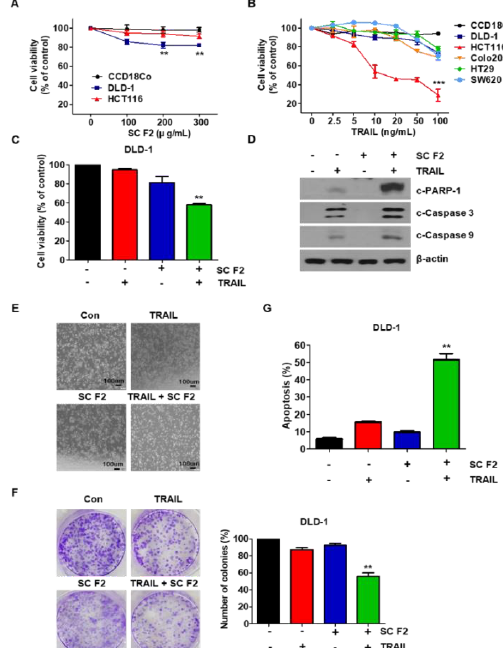
Figure 1. Sea cucumber ( SC) F2 significantly activated TNF-related apoptosis-inducing ligand (TRAIL)-induced apoptosis of human colorectal cancer (CRC) cell lines. ( A ) Cytotoxicity of SC F2 ( B